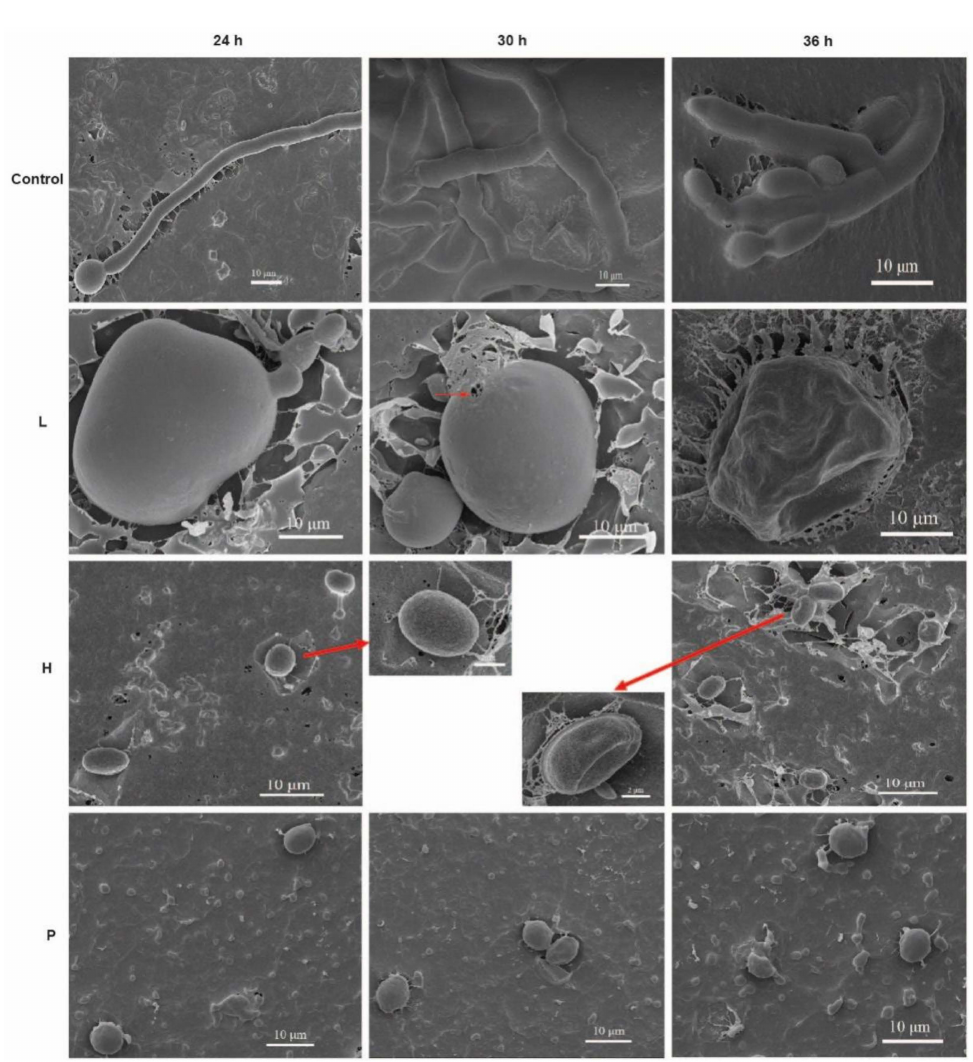
Figure 6. Bacillus subtilis L1-21 culture filtrate were tested against the pathogen. Spore germination and morphology were observed under a scanning electron microscope. Deformed spores were present in the presence of culture filtrate of B. subtilis L1-21. L means low concentration (5-fold dilution from higher concentration) of B. subtilis L1-21 Landy culture filtrate, H means high concentration of B. subtilis L1-21 Landy culture filtrate ( B. subtilis L1-21 was cultured in Landy medium for 72 h), P means prochloraz (Fungicide widely used in China for controlling citrus fruit green mold) (positive control). 3.5. Stability of Bacillus Subtilis L1-21 Culture Filtrate under Different Conditions The stability of B. subtilis L1-21 culture filtrate present in Landy medium was